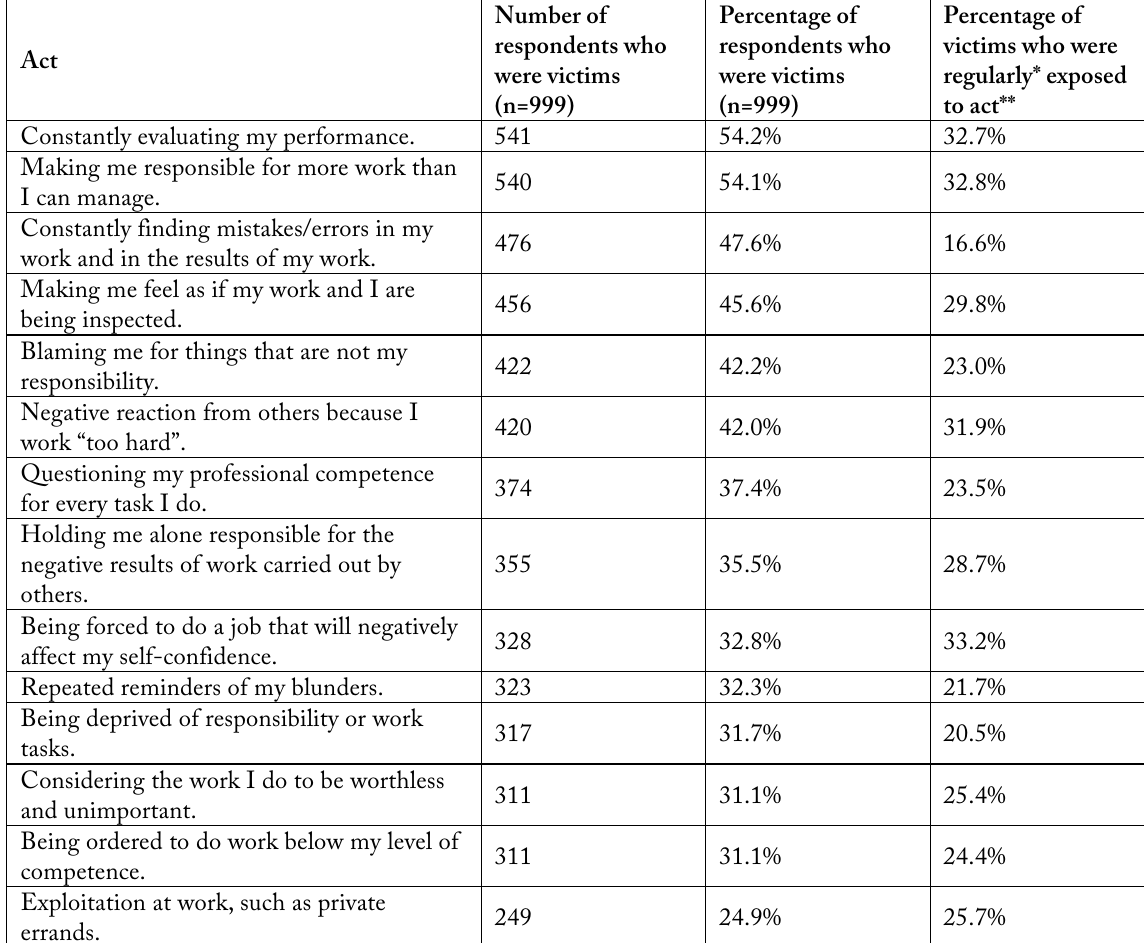
Table 4: Respondents who experienced behaviour undermining their professional status